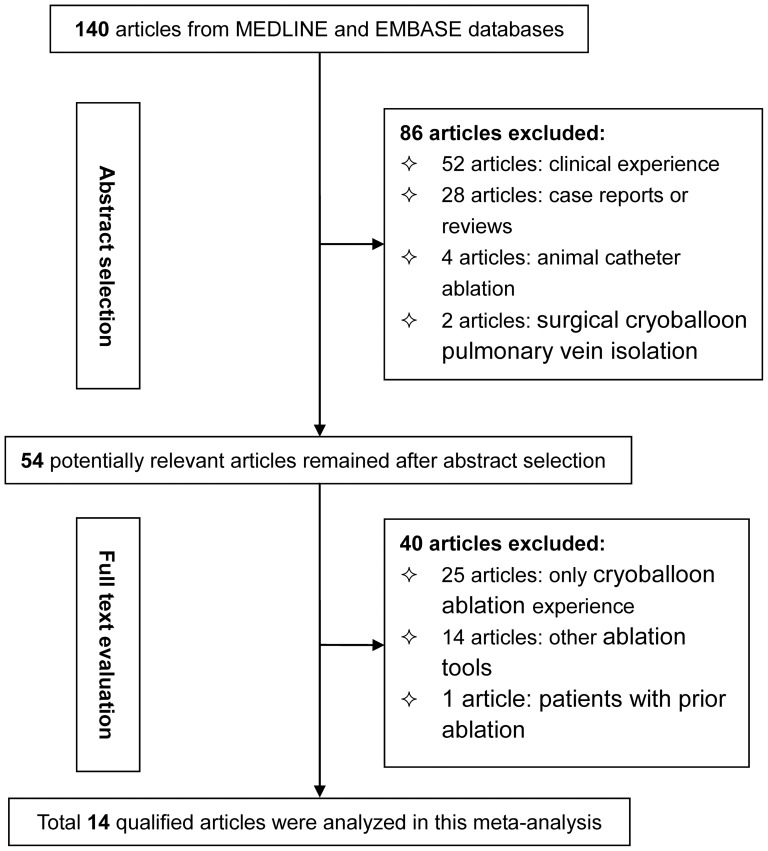
Flow diagram of search strategy and study selection.